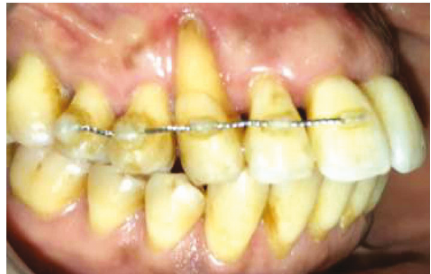
Figure 14: 39 months ’ recall check-up showing a complete disappearance of the purulent discharge with a buccal bone loss and gingival recession regarding number 13.